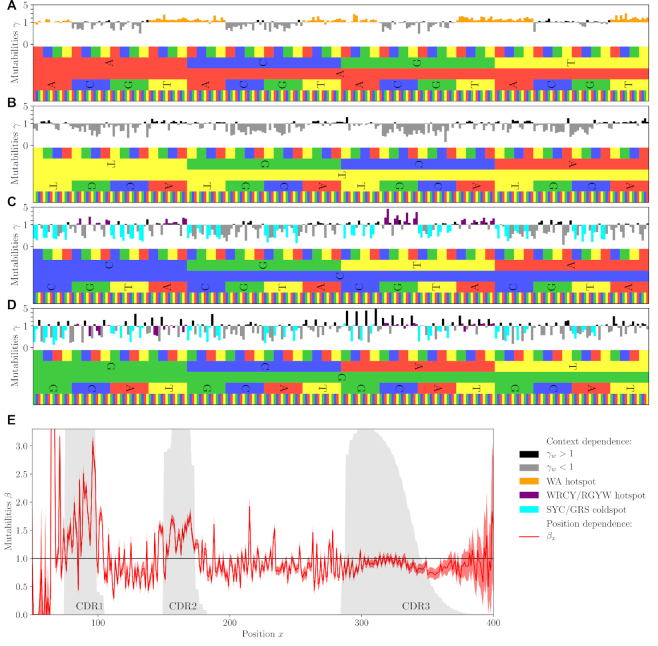
Context and position dependent model parameters. Context-dependent mutabilities γ\documentclass[12pt]{minimal}
\usepackage{amsmath}
\usepackage{wasysym}
\usepackage{amsfonts}
\usepackage{amssymb}
\usepackage{amsbsy}
\usepackage{upgreek}
\usepackage{mathrsfs}
\setlength{\oddsidemargin}{-69pt}
\begin{document}
}{}$w$\end{document} for A- (A), T- (B) ,C- (C) and G-centered (D) 5-mers. The colors indicate known hopspot and coldspot motifs. (E) Position-dependent mutabilities βx. Gray shadings show the probability to be in the CDR1, CDR2 or CDR3 regions. Error bars correspond to \documentclass[12pt]{minimal}
\usepackage{amsmath}
\usepackage{wasysym}
\usepackage{amsfonts}
\usepackage{amssymb}
\usepackage{amsbsy}
\usepackage{upgreek}
\usepackage{mathrsfs}
\setlength{\oddsidemargin}{-69pt}
\begin{document}
}{}$95\%$\end{document} confidence intervals. See Supplementary Figure S5 for an full analysis of parameter uncertainty.